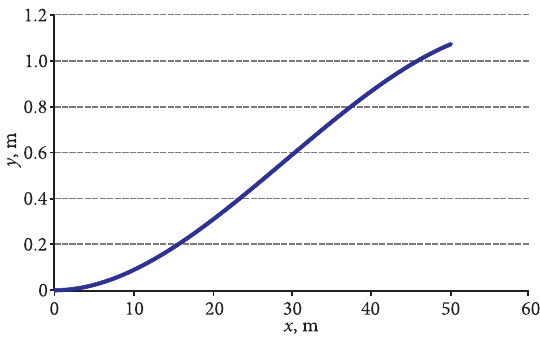
Fig. 3. Horizontal ordinates y ( x ) chart, described by the formulas (14), (15), (19) and (20) for S -shaped joining of circular arcs with curvatures rad/m and rad/m ( l k = 50